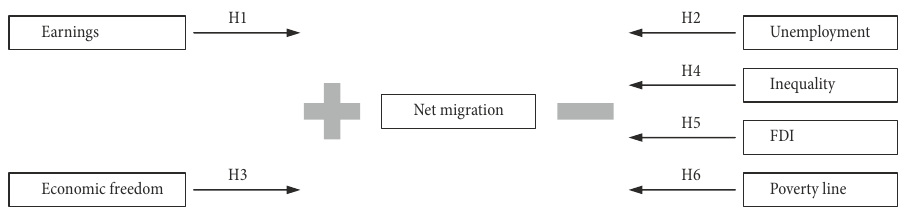
Fig. 2. Hypotheses